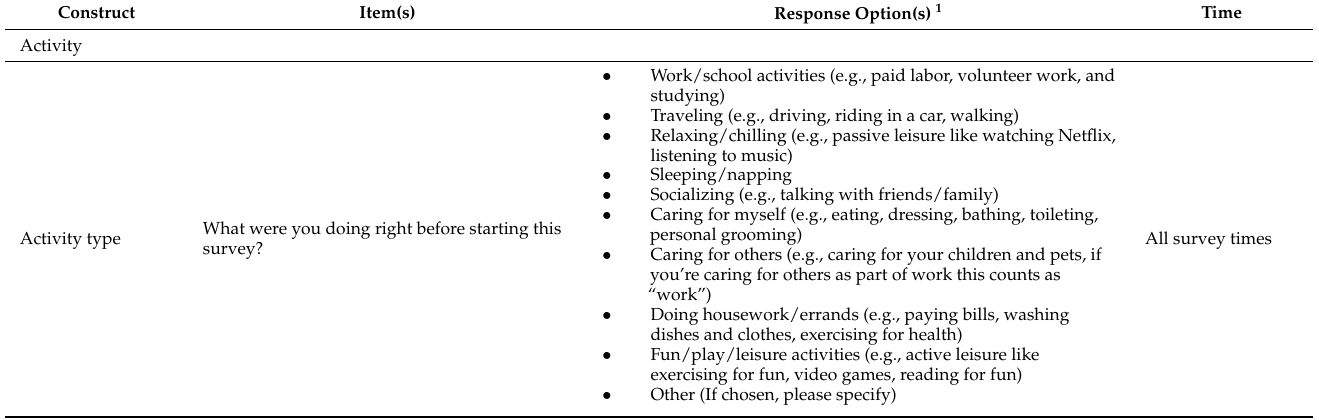
Table 2. Ecological momentary assessment measures administered over up to 14 days of data collection.